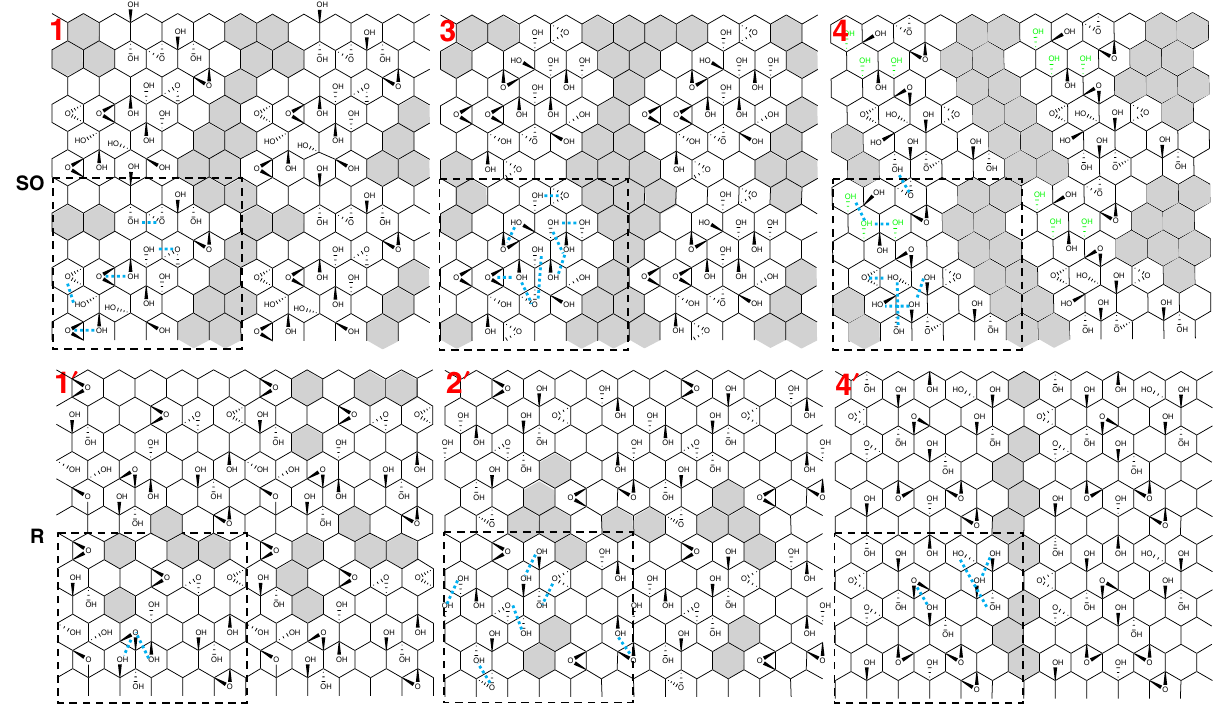
Fig. 1 Models of graphene oxide studied in this work. Semiordered (SO, top) and random (R, bottom) models of graphene oxide generated and studied as part of this work. Each material is designed according to a 25% O/C functionalization rate, and the oxygen-bearing groups are hydroxyls and epoxides with a 2:1 ratio. Gray hexagons are a guide for the eye, indicating the areas of pristine graphene, where no chemical function is grafted. Double C = C bonds are not drawn as double bonds, for the sake of clarity. All the con fi gurations are represented as a 2 × 2 supercell of the graphene oxide model (the cell size is indicated in dotted lines on the top-left panel). Numbering of the models corresponds to Table 1. Intramolecular hydrogen bonds in GO are indicated by light-blue dotted lines, and the special reactive motif of three consecutive hydroxyl groups in the semiordered 4 model is colored in light